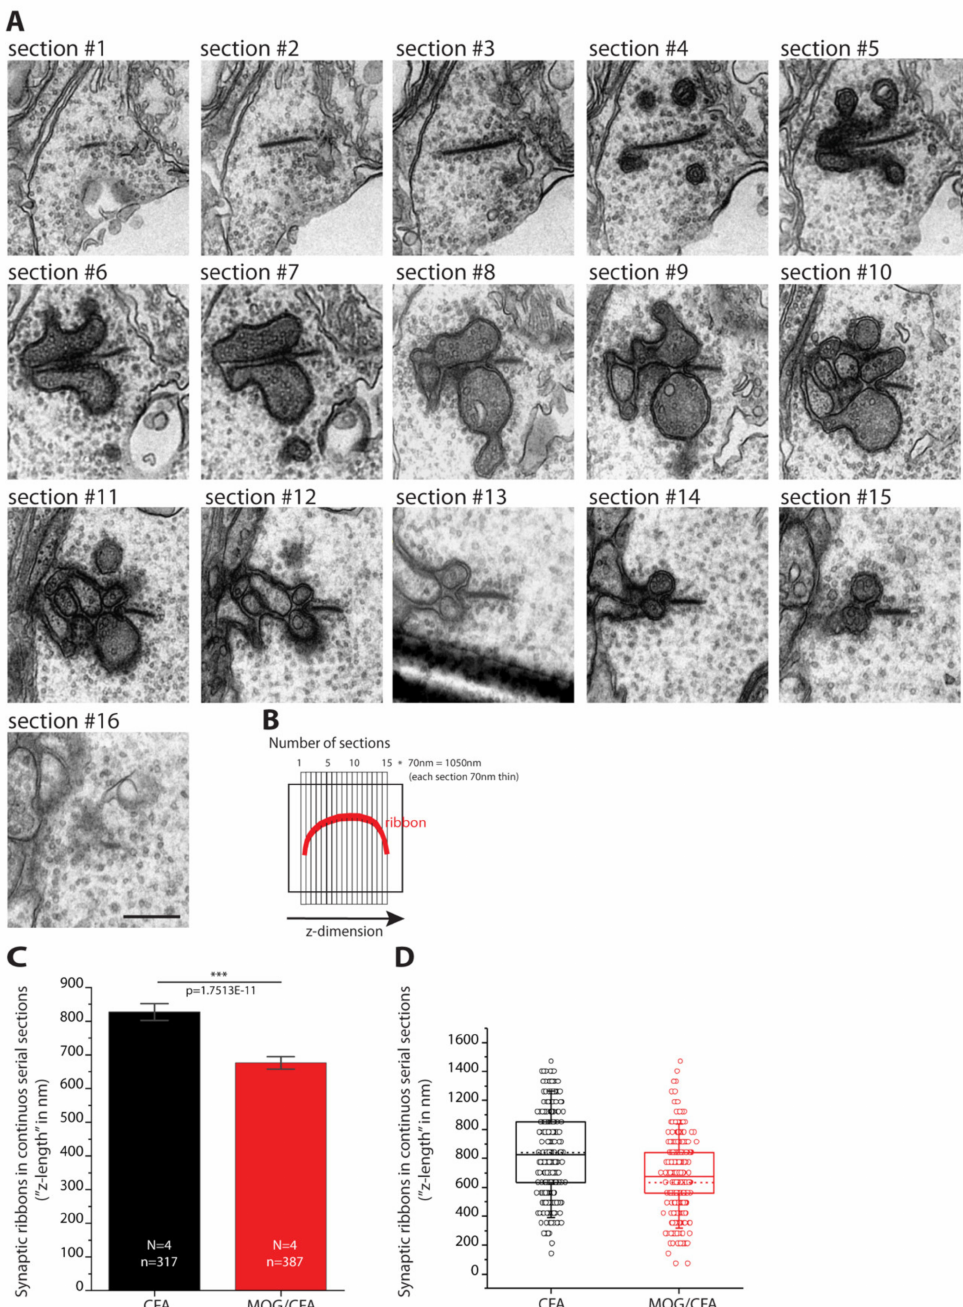
Figure 5. Synaptic ribbon length (“z-length”) in rod photoreceptor synapses of early pre-clinical EAE mice is shorter than in control littermate mice, as judged by transmission electron microscopy of serial ultrathin sections. ( A ) Representative electron microscopic images of a single photoreceptor ribbon synapse acquired from serial ultrathin retina sections of a CFA-injected control mouse obtained 9 days after injection. ( B ) schematically demonstrates how the z-length of rod synaptic ribbons was determined by counting the number of ultrathin sections in which an individual synaptic ribbon is present. Values in ( C ) are means ± S.E.M. of the synaptic ribbon length in z-direction (827 nm ± 16 nm in CFA-injected control mice and 677 nm ± 12 nm in MOG/CFA-injected EAE mice). In the box-and-whiskers plot ( D ) of the data from ( C ), mean values are indicated by solid horizontal lines; median values by dotted horizontal lines. Boxes represent the 25th–75th percentiles of data points and whiskers are equal to 1.5 times of the interquartile range (IQR). Mann–Whitney U-test was used to determine the statistical significance. N, number of mice; n, number of ribbon synapses analyzed to measure the z-axis length; ***, p ≤ 0.001. Scale bars: 500 nm (scale bar in section #16 applies to all